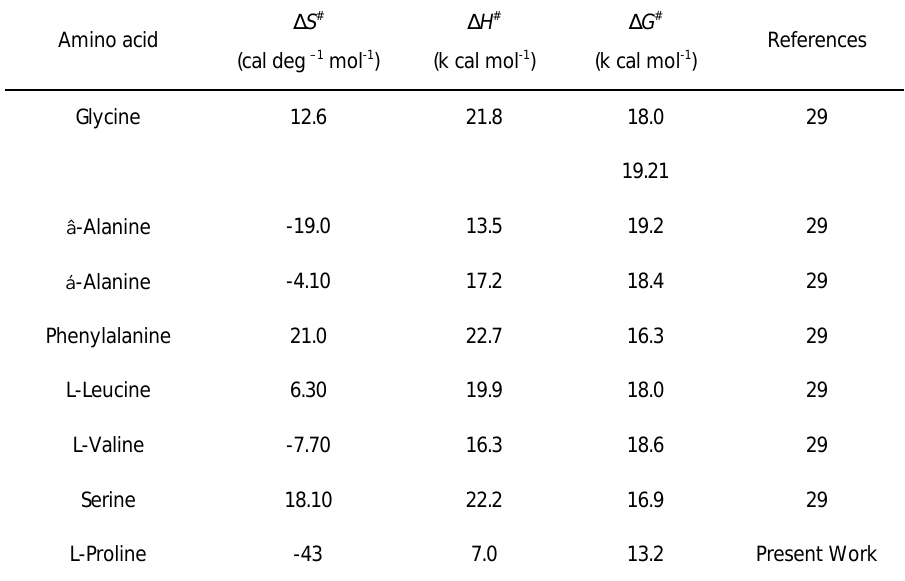
Table 3Table 3. Activation parameters for some amino acids (for isokinetic